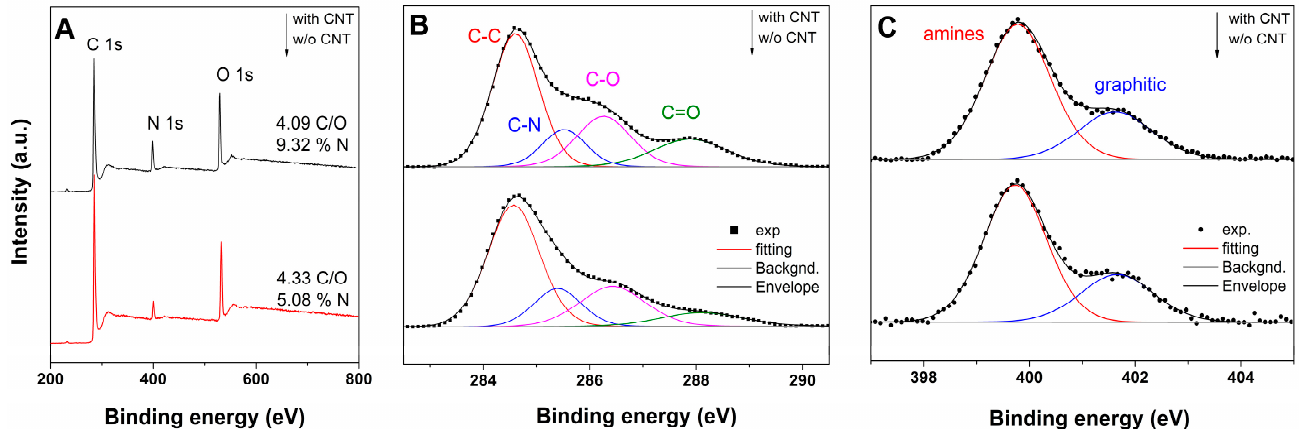
Figure 5. XPS survey scan ( A ); deconvoluted C 1s ( B ) and O 1s spectra ( C ) of PAMAM-modified (0.2 mg mL − 1 ) aerogel in absence and presence of 0.03 mg mL − 1